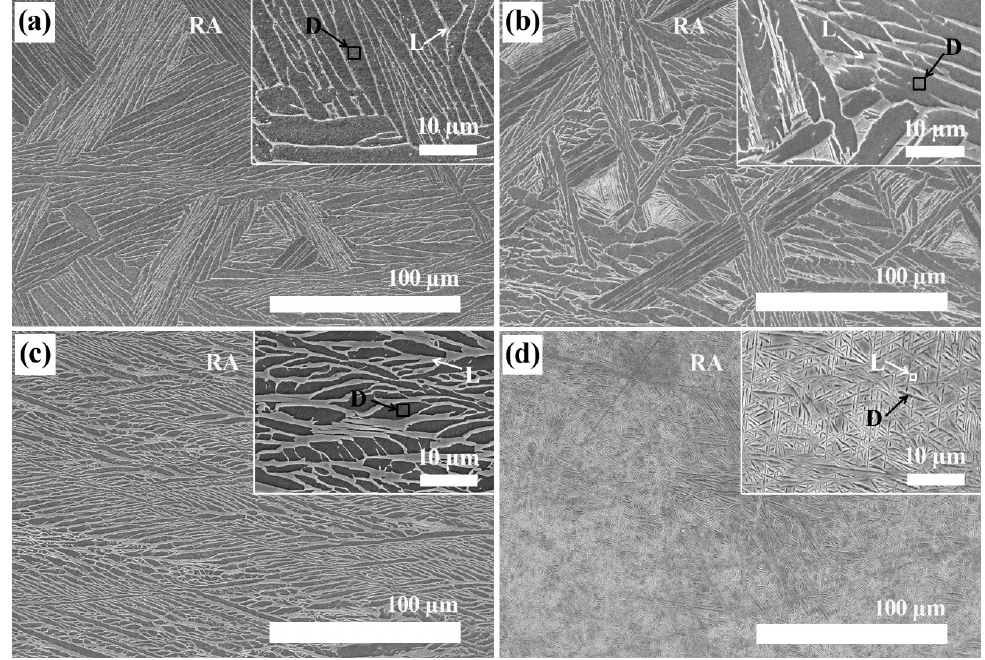
Figure 2. Low-magnification and higher-magnification (inset) SEM images of ( a ) Ti-5Nb; ( b ) Ti-10Nb; ( c ) Ti-15Nb; and ( d ) Ti-20Nb alloys. (RA: rectangular area, 250 µm × 170 µm, D: dark region, L: light region). Table 1. EDX (energy dispersive X-ray) analysis results obtained from selected areas in Figure 2 ( n = 5).